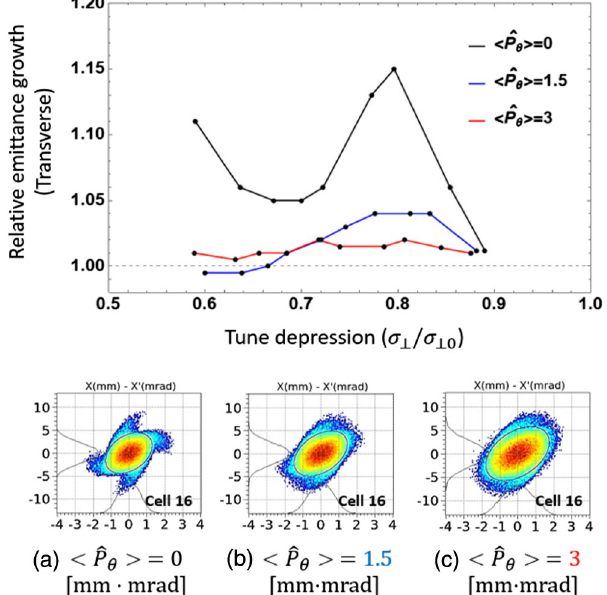
FIG. 4. Relative emittance growth over 20 periods along the solenoid focusing lattice for σ ⊥ 0 ¼ 100 ° without acceleration. Emittance growth results mainly from the fourth-order particle resonance. The phase-space plots for cell 16 are shown for the